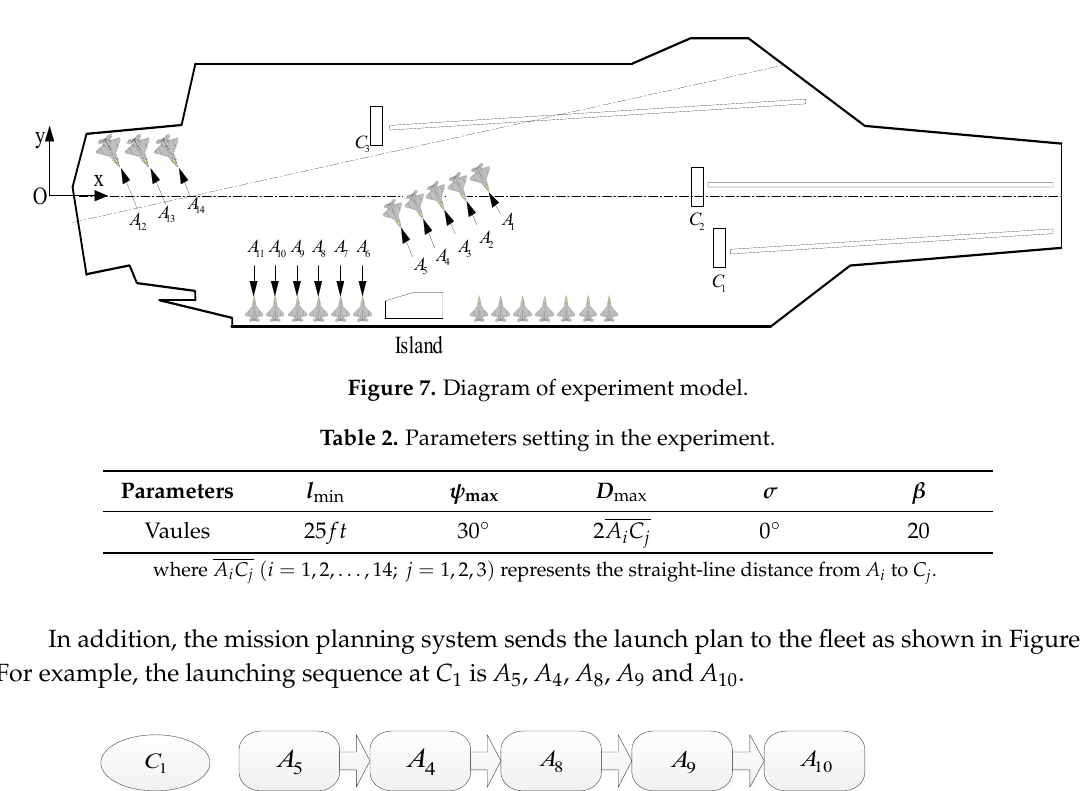
within its range. After